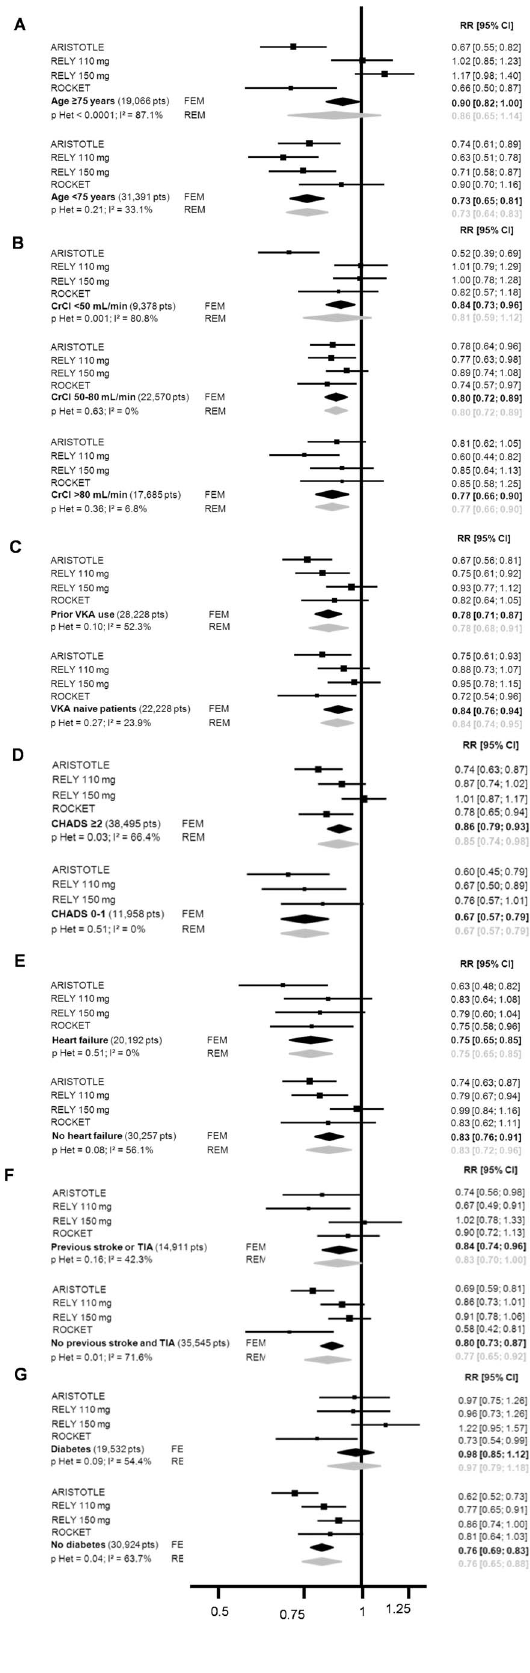
Figure 4. Detailed forest plot of major bleeding according to (A) age, (B) renal function, (C) prior VKA exposure, (D) CHADS 2 score, (E) heart failure, (F) prior stroke or transient ischemic attack, (G) diabetes